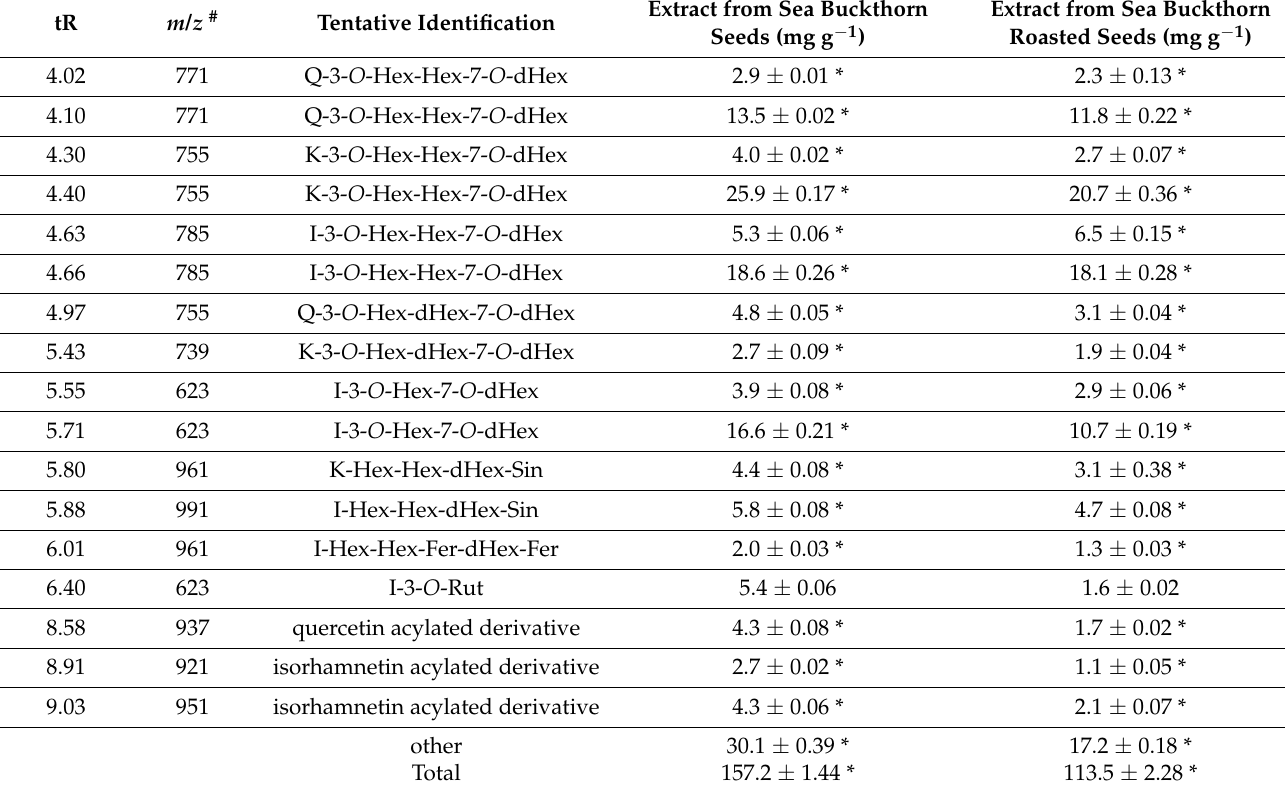
Table 1. Flavonoids in extracts from sea buckthorn